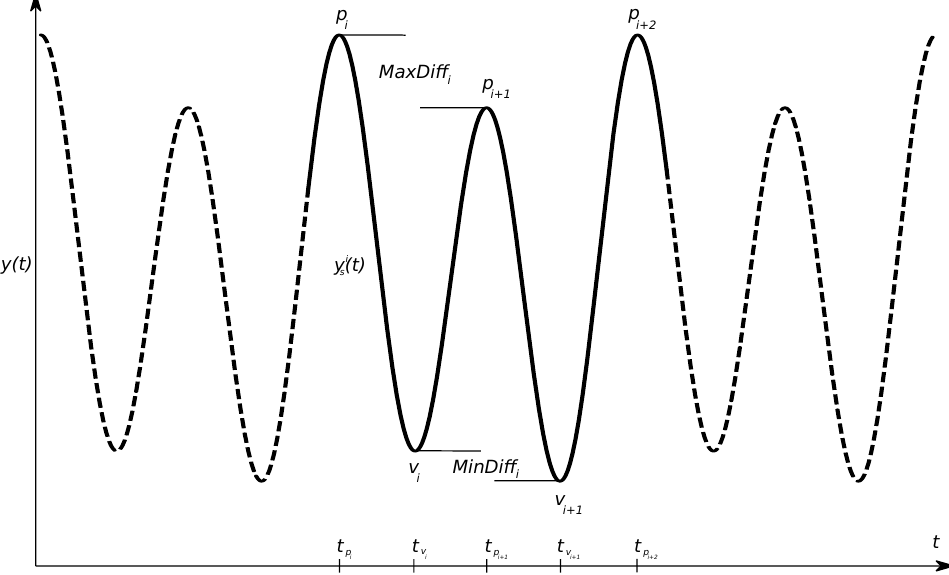
Figure 3. Example of the vertical displacement signal from head or pelvis, with local minima denoted with v for valley and local maxima with p for peak. Metrics for lameness quantification are calculated as the difference between the two minima (MinDiff) and the two maxima (MaxDiff) per stride. A stride segment y i s ( t ) was defined as the section of y ( t ) , starting at t p